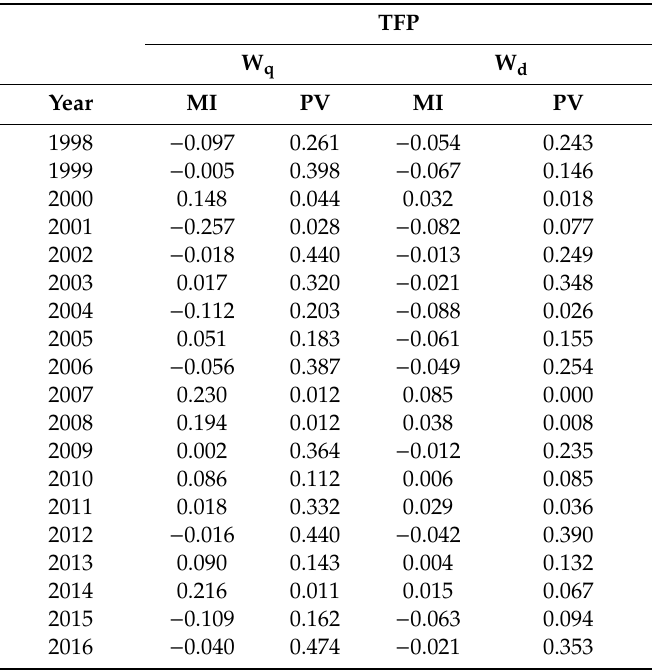
Table 5. Global Moran index of the GTFPI from 1998 to 2016.